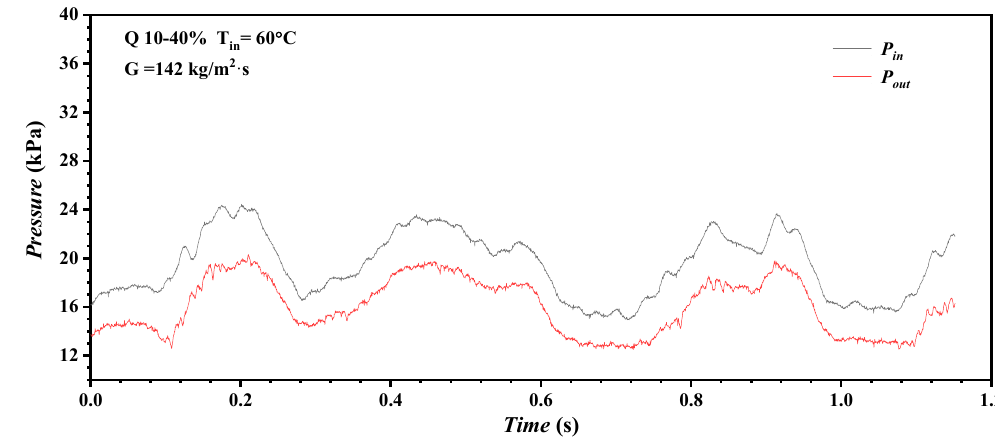
Figure 13. Visual images of sample Q10-20% (q eff = 121.2 W/cm 2) . Circle region: explosive boiling; Arrow:flow direction; blue line: vapor mass boundary. Arrow: flow direction; blue line: vapor mass boundary.